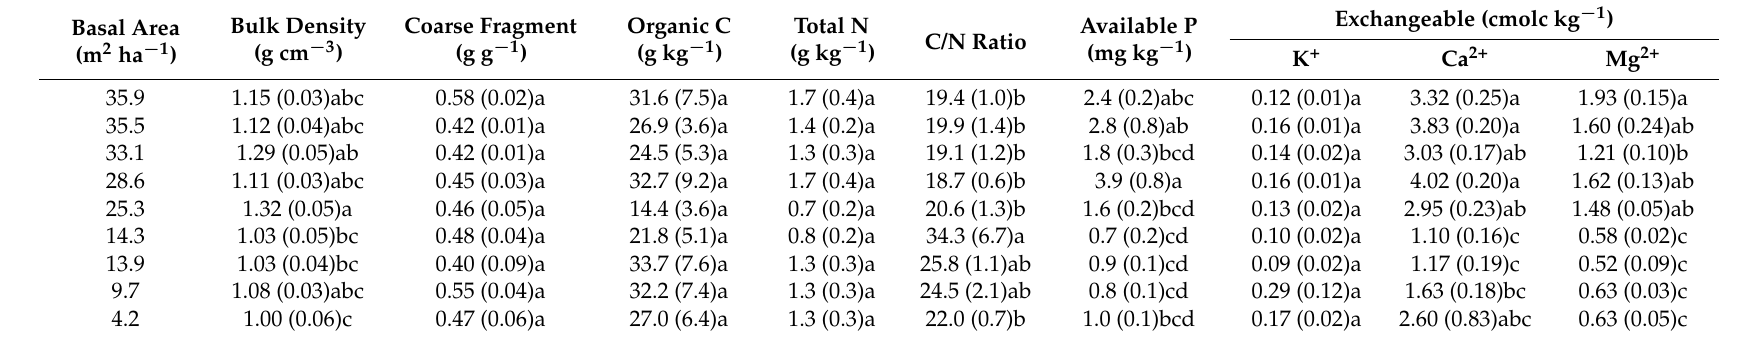
Table 2. General soil properties in pine wilt disease disturbed stands ( n =